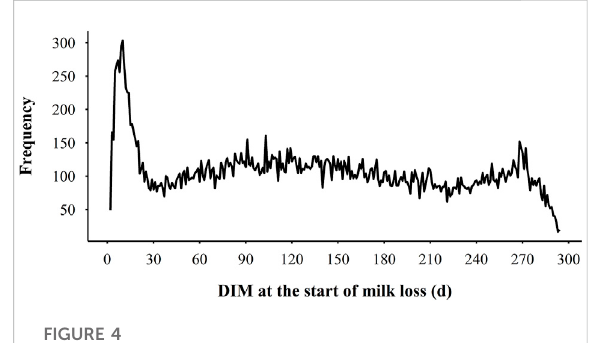
FIGURE 4 Thedistributionofdaysinmilk (DIM)atthestartofmilk lossin each